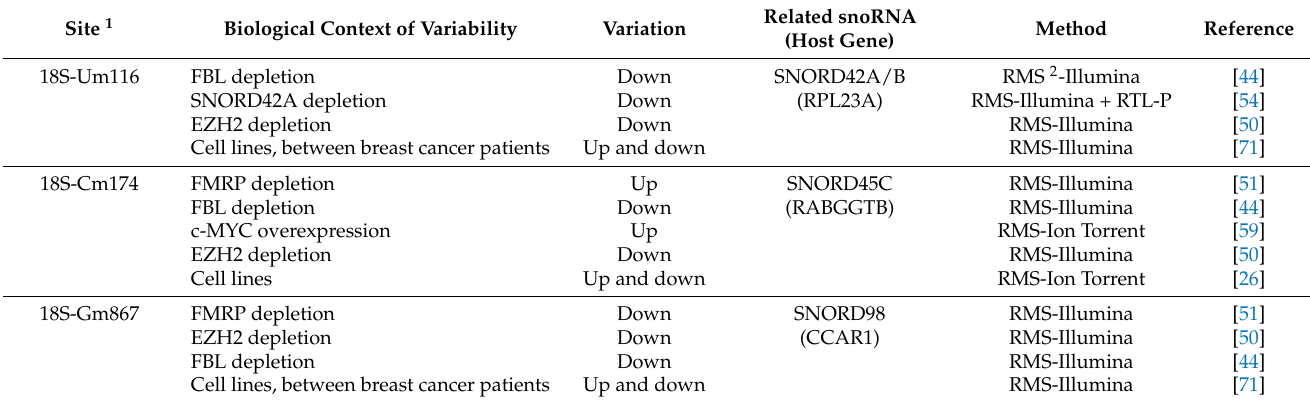
Table 2. The twelve most referenced human rRNA 2 (cid:48) Ome sites showing